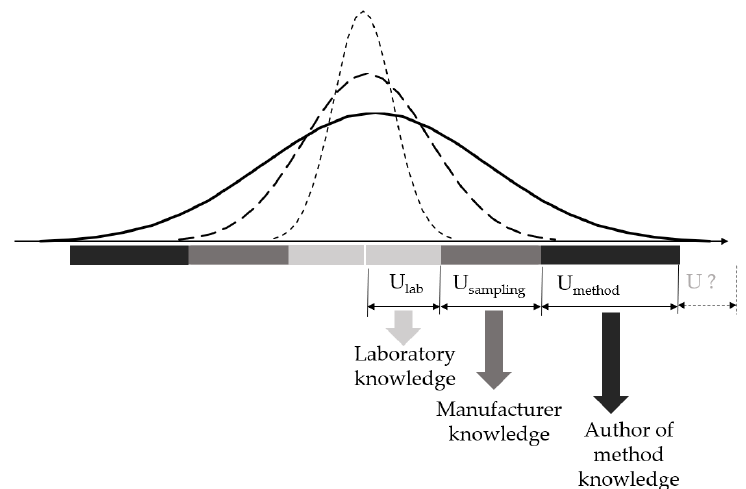
Figure 4. Illustrative drawing showing dispersed knowledge about the test result uncertainty. U lab — uncertainty estimated based on laboratory knowledge, including knowledge of repeatability standard deviation. U sampling —sampling uncertainty can be estimated based on the manufacturer’s knowledge. U method — test method uncertainty (dark uncertainty), which can be estimated based on a validation experiment preceding the test method implementation.